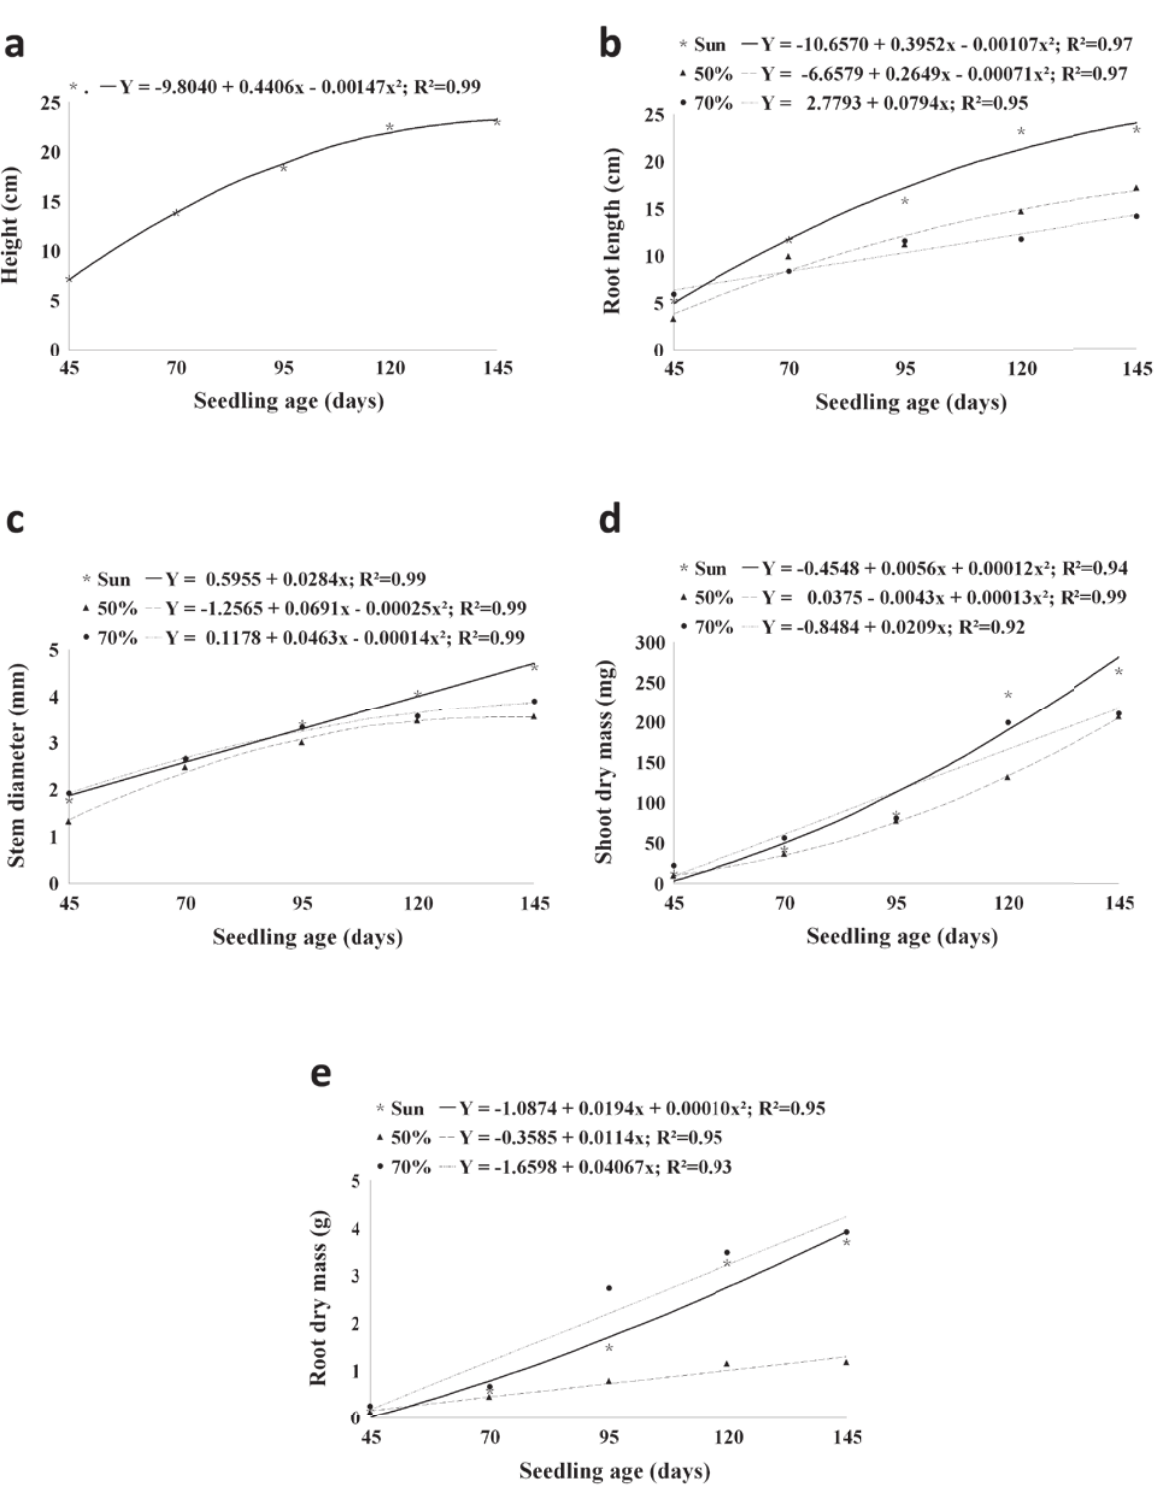
Figure 1 - Height (a) , root length (b) , stem diameter (c) , shoot dry mass (d) and root dry mass (e) of Myracrodruon urundeuva ALLEMÃO seedlings due to their